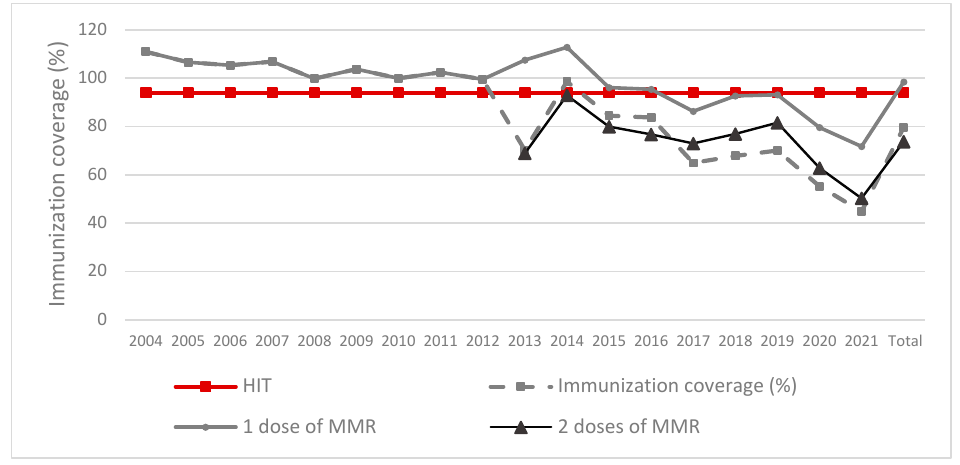
Figure 1. Annual measles vaccine coverage (%) in Brazil, 2004–2021, based on administered doses. Note: the 1 dose of MMR curve is higher than 100% because it documents the ratio of the number of doses applied and the total number of individuals in the population for each respective age group. Since the census is retrospective, a larger number of individuals are available for vaccination [7]. HIT: herd immunity threshold; MMR: measles, mumps,